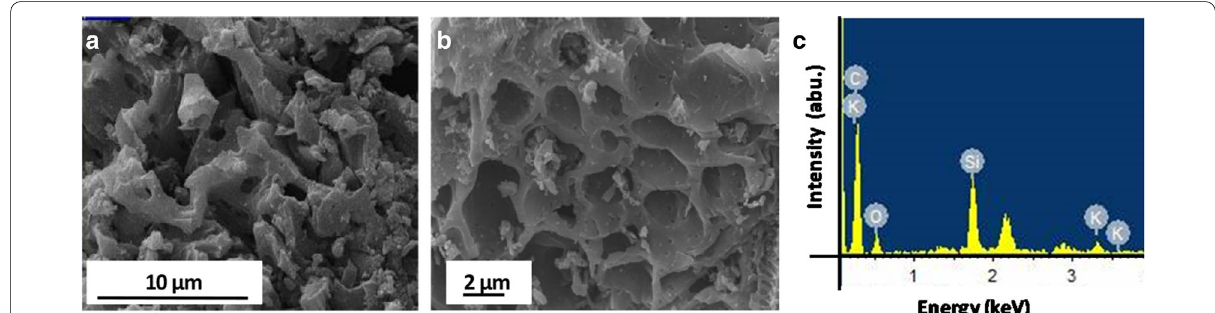
Fig. 3 a SEM image (bar scale 10 μm), b SEM image (bar scale 2 μm), and c EDAX profile of as-prepared